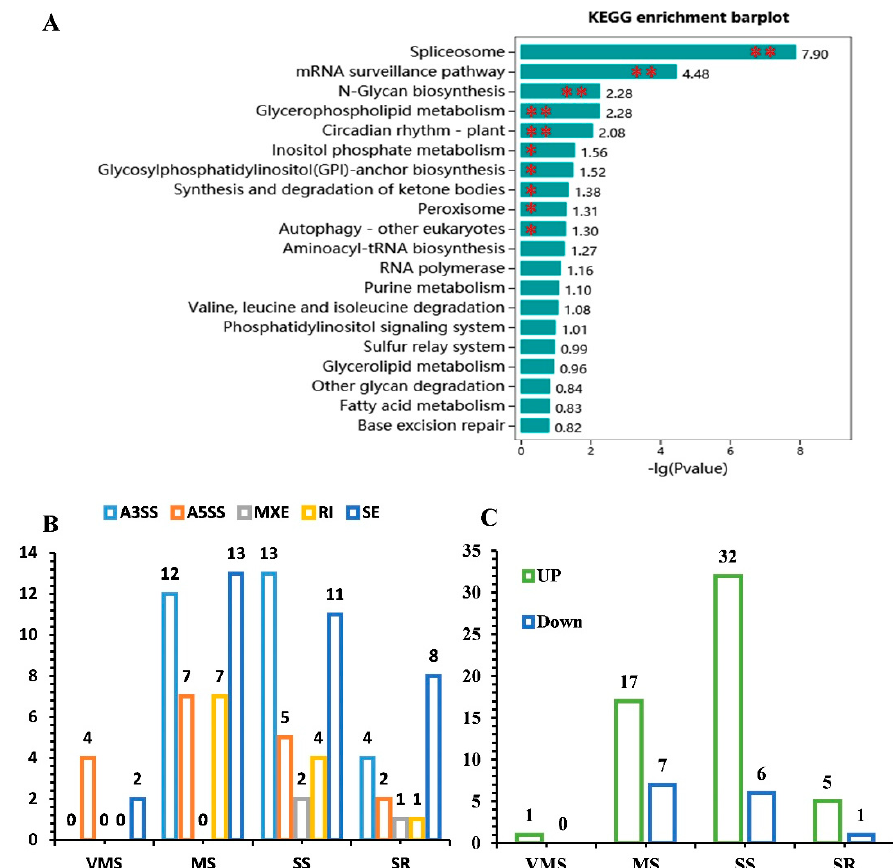
Figure 6. Expression and AS analysis of splicing regulatory factors (SPF)-related genes in response to various drought treatments. ( A ) The 20 most enriched Kyoto Encyclopedia of Genes and Genomes (KEGG) pathways ( G. max . L.) of DSGs. The − Log10 ( p value) was used to indicate the ratio of the DSG number and the number of genes annotated in this pathway. The greater the − Log10 ( p value), the greater the degree of enrichment. **, p < 0.01; *, p < 0.05. ( B ) The number of significantly di ff erentially spliced SPF-related genes identified under various drought retreatments. ( C ) The number of significantly di ff erentially expressed SPF-related genes identified under various drought retreatments.